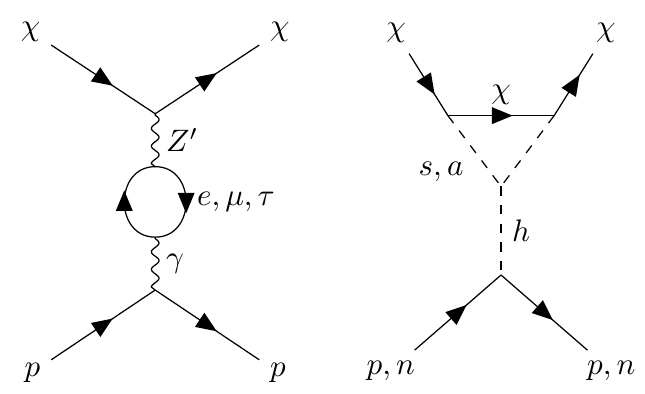
Figure 7. Direct detection channels of the dark matter candidate χ .